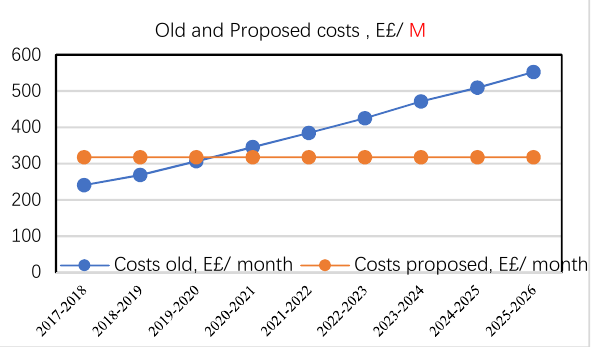
Figure 10. Comparison between the old and proposed hybrid system costs/month for residential “from 2017/2018 to 2026/2027”.